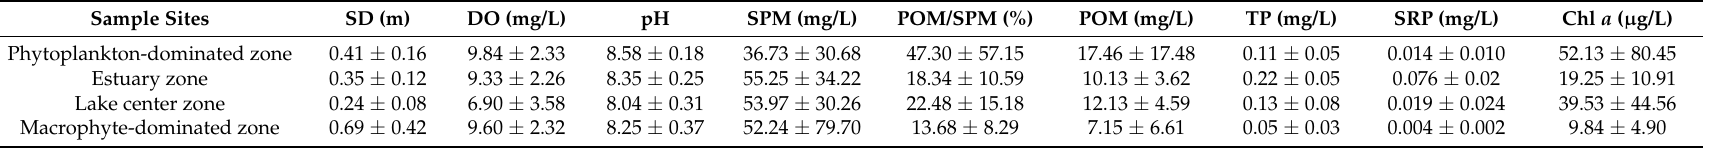
Table 1. The variation of physical and chemical parameters in different ecological type zones of Lake Taihu: transparency (SD), dissolved oxygen (DO),